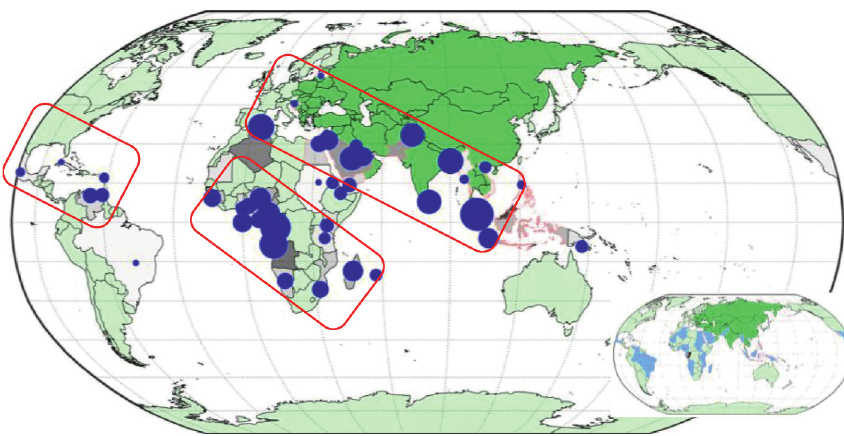
Figure 19: China’s overseas shipping construction projects